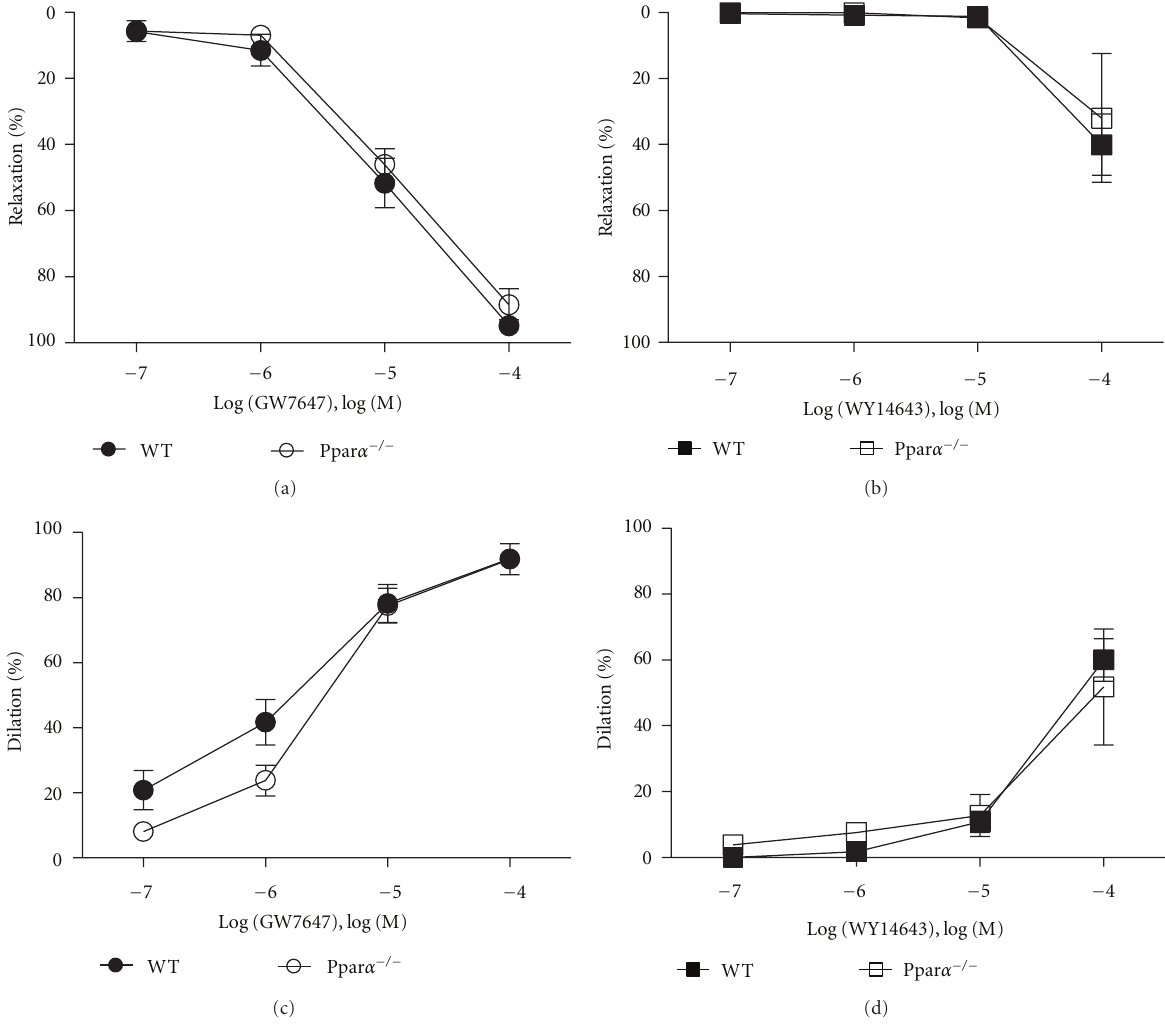
Figure 2: Nonreceptor-mediated responses to PPAR α agonists. Concentration responses to GW7647 and WY14643 in aortic rings (a) and (b) and in MCAs (c) and (d) isolated from WT and Ppar α − / − mice ( n = 3–5). Responses to GW7647 and WY14643 in aortic rings and MCAs of Ppar α − / − mice were identical to that of WT (control) mice indicating a receptor-independent e ff ect. Data are means ± SEM. ∗ Indicates P ≤